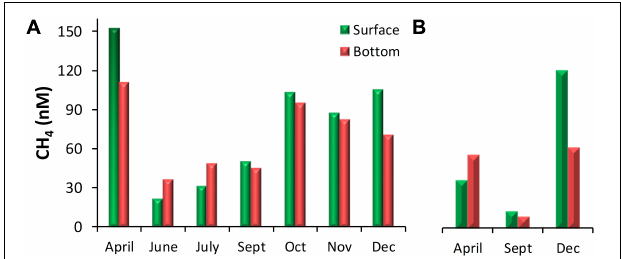
FIGURE 3 | Seasonal distribution of (A) temperature ( ◦ C), (B) salinity, (C) dissolved oxygen ( µ M), and (D) methane (nM) off Mangalore.